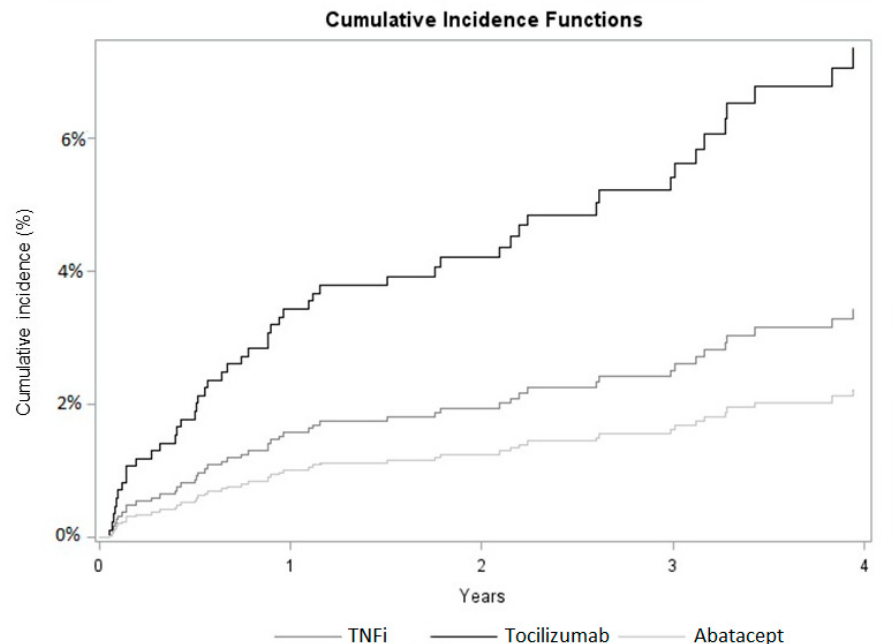
Figure 2. Cumulative incidence functions of severe infections stratified by bDMARD used at cohort entry. Estimates derived by the Fine and Gray model.